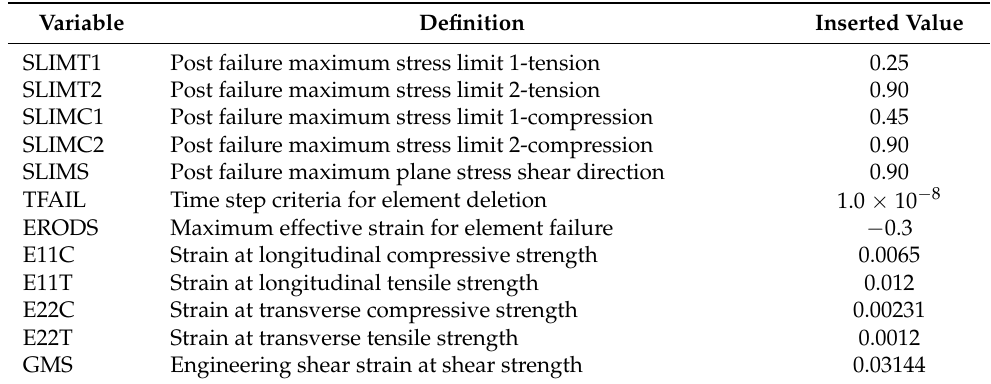
Table 5. MAT58 intralaminar numerical